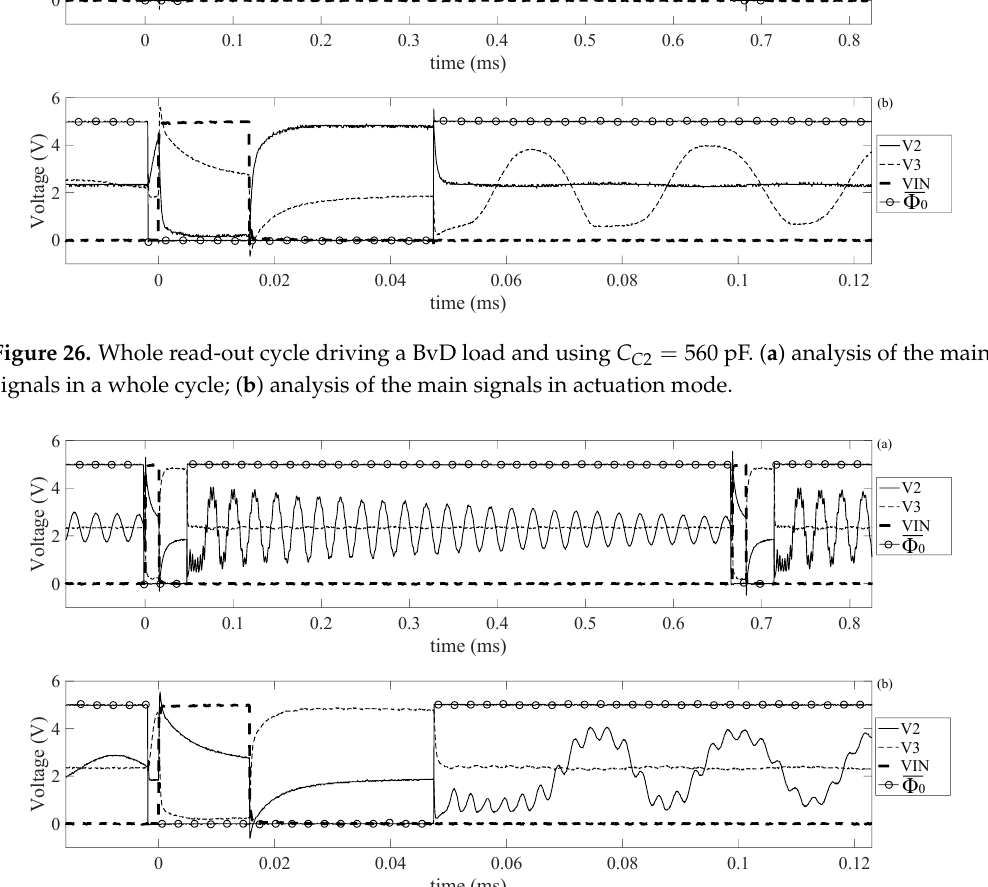
Figure 27. Whole read-out cycle driving a real piezoelectric sensor and using C C 2 = 250 pF. ( a ) analysis of the main signals in a whole cycle; ( b ) analysis of the main signals in actuation